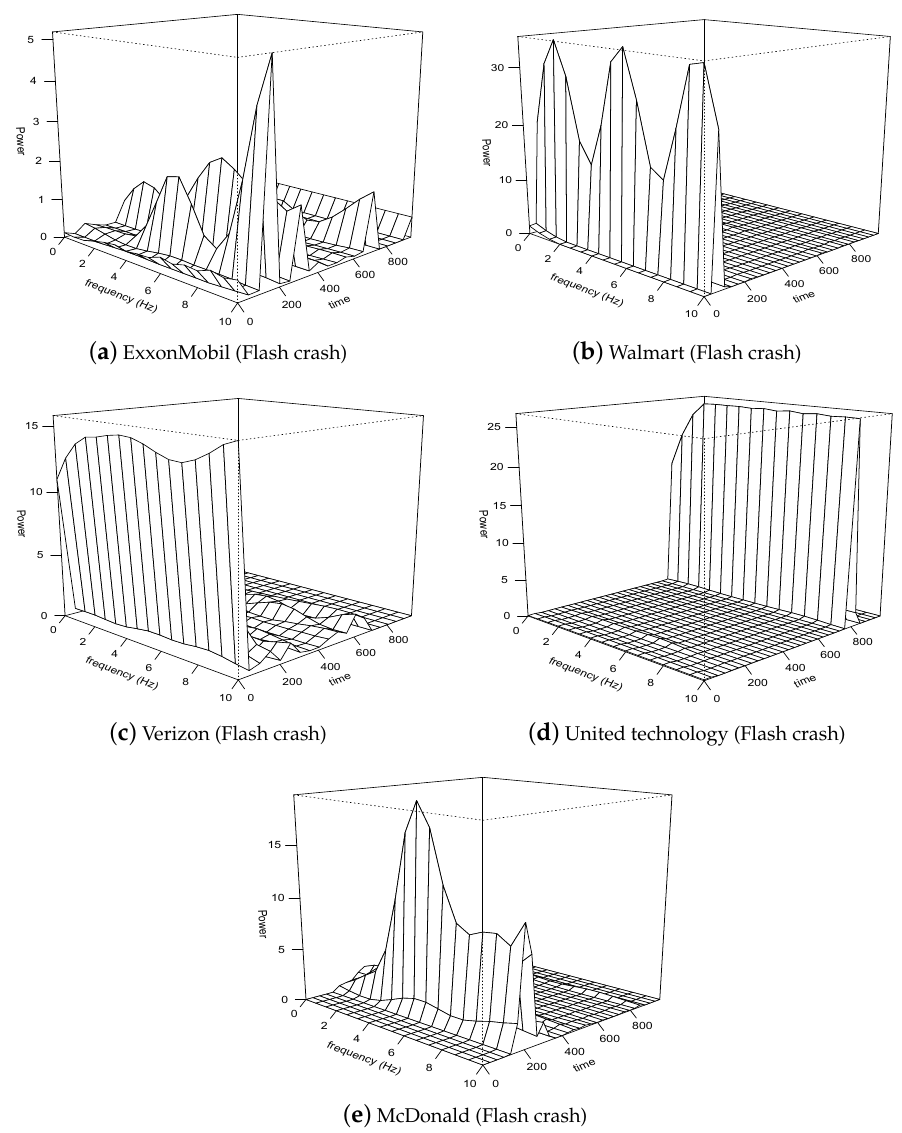
Figure 5. The energy levels of financial data corresponding to the flash crash event.